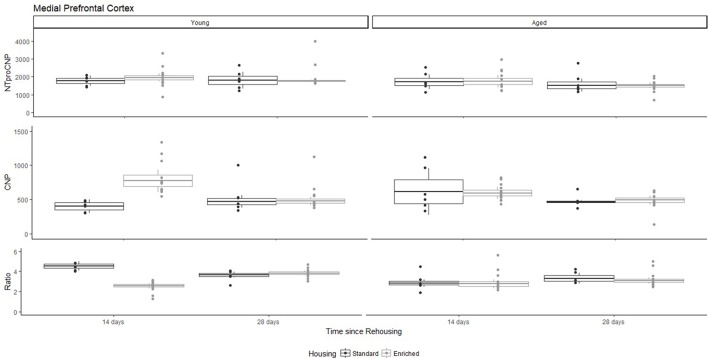
Concentration (femtomoles/g wet tissue) of NTproCNP (Top), CNP (Middle), and NTproCNP:CNP ratio (Bottom) within medial prefrontal cortex. Summary data is 20% trimmed means (resulting in a reduction of n = 2 for all groups), standard error (box) and 95% confidence interval (whisker), overlaid by individual data points. For NTproCNP: Aged rats < Young rats. For CNP: Young-Enriched-14-day > Other Young rats; Aged-14-day > Aged-28-day. For Ratio: Young-Enriched-14-day = Aged overall < Other Young rats.